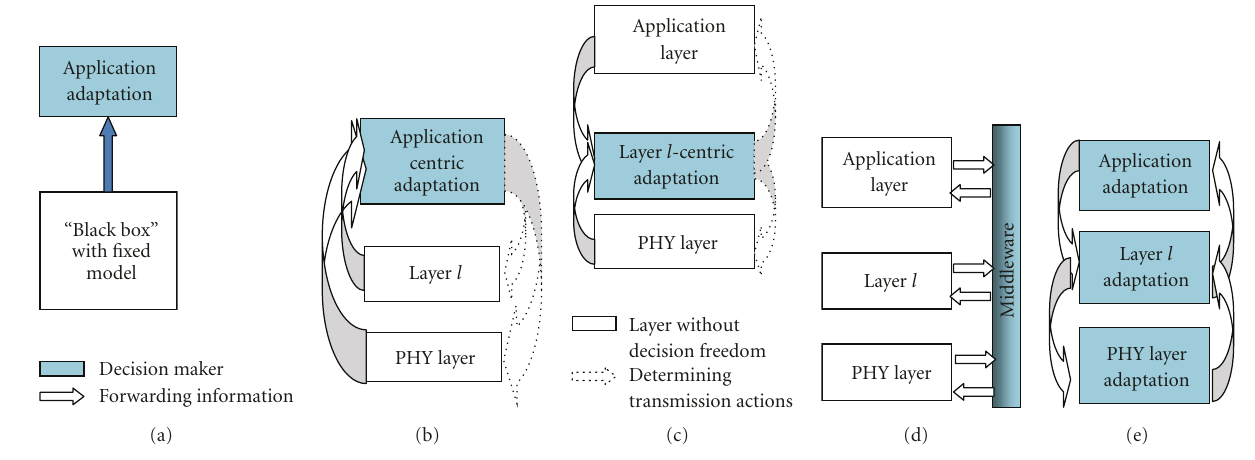
Figure 1: Conceptual illustration of cross layer optimization